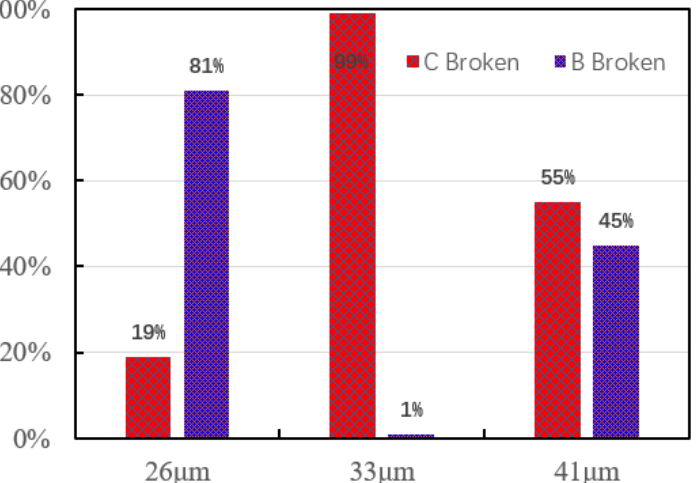
Figure 7. Statistical diagram of the breakpoint position of the ball bonded point with IHDs of 26, 33 and 41 μ m respectively.